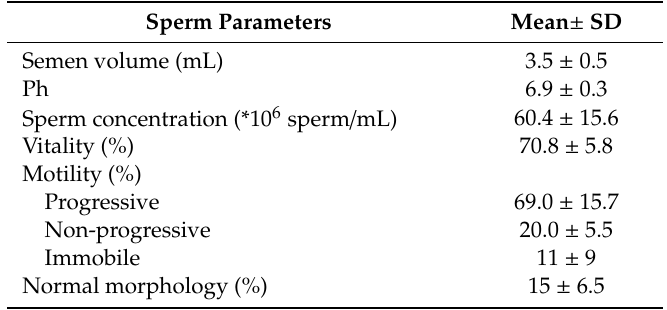
Table 2. Parameters of semen fluid selected for the study. Sperm parameters were expressed as mean ±